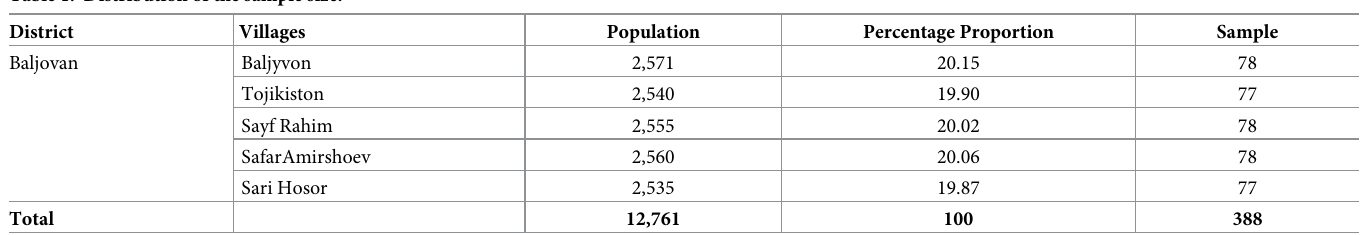
Table 1. Distribution of the sample